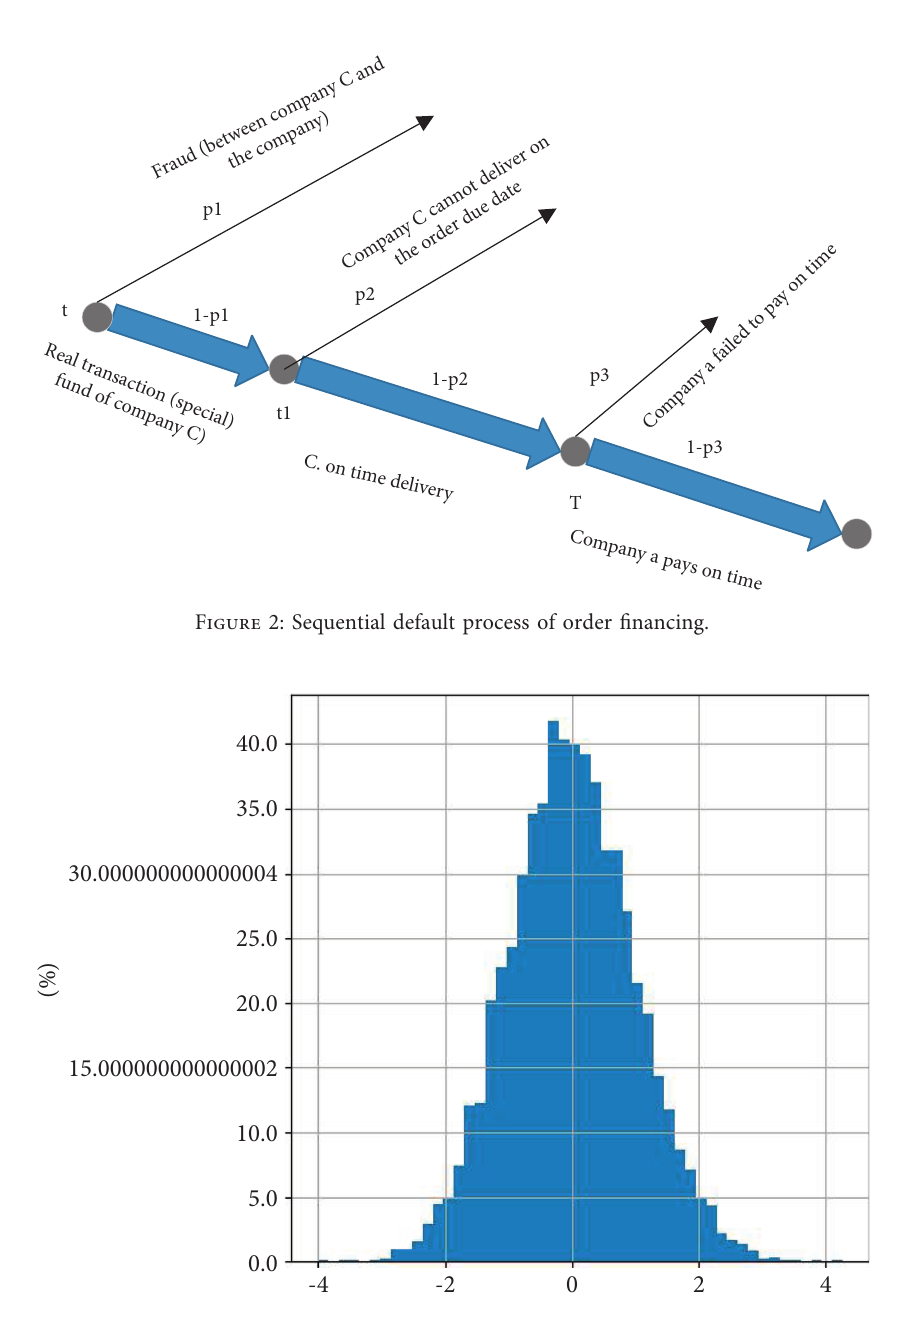
Figure 3: LGD bimodal distribution.